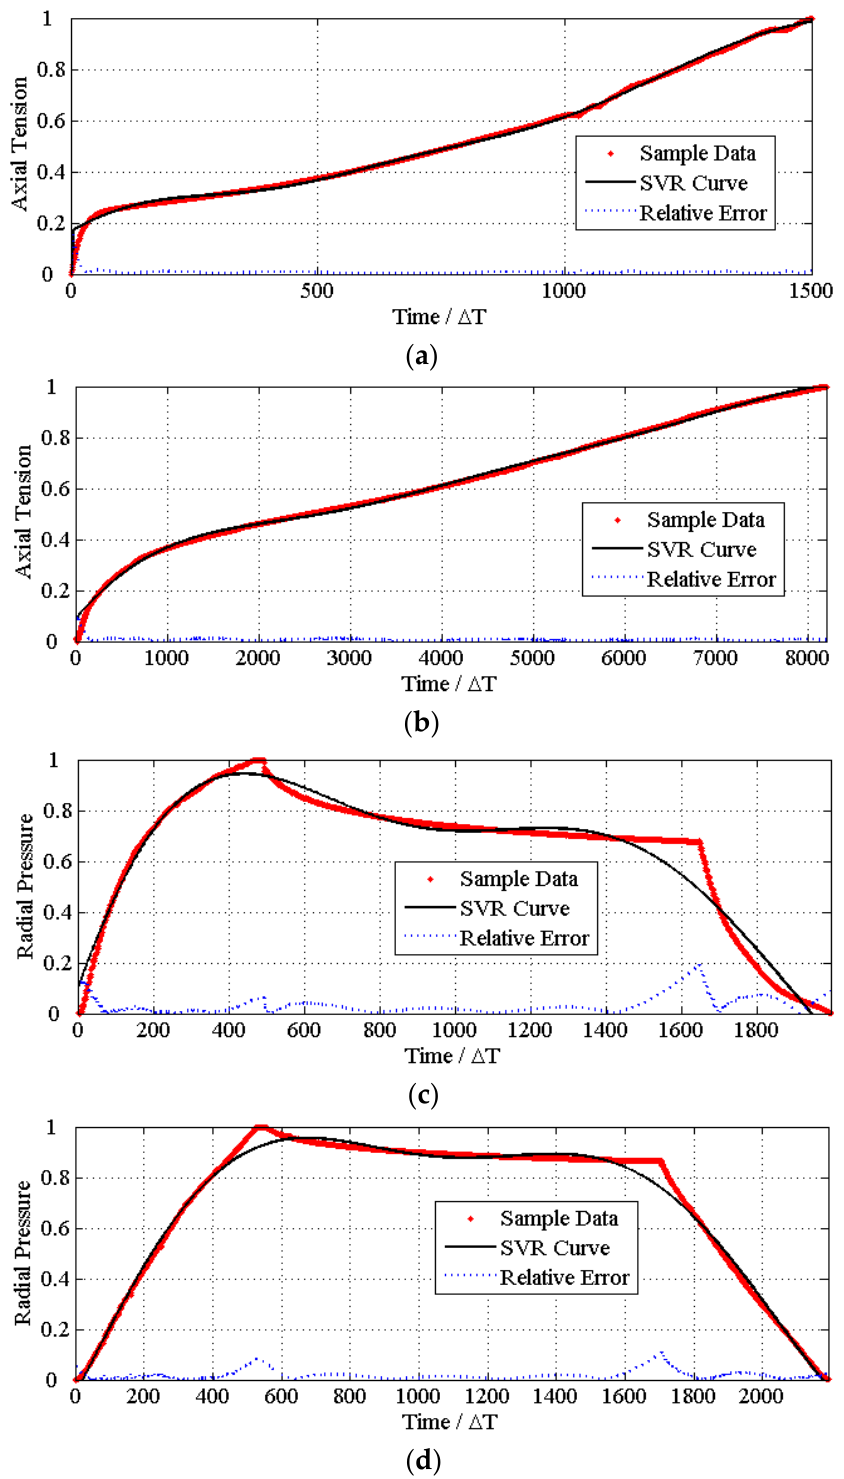
Figure 8. The time series of the ureteral stent’s properties. ( a , b ) The axial tension properties with the regression errors of SVR Mixed and SVR CoPU , respectively; ( c , d ) the radial pressure properties with the regression errors of each.